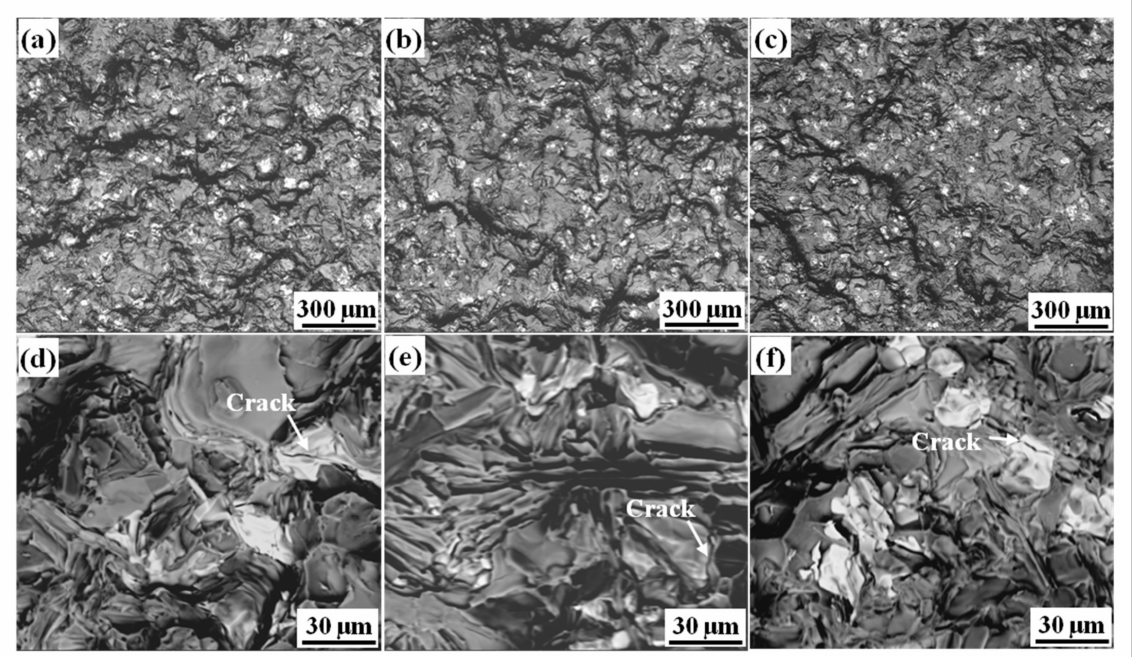
Figure 7. Fracture morphology of alloys under different Fe content: ( a , d ) 0.8%; ( b , e ) 1.8%; ( c , f )